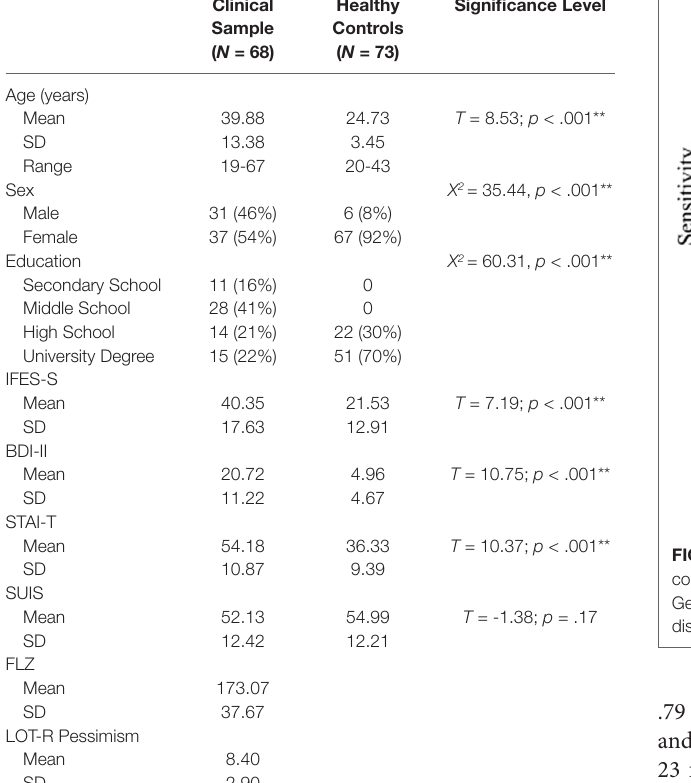
TABlE 3 | Demographic Characteristics of the sample, as well as mean scores, standard deviations, and significance levels of the measures. Clinical Sample